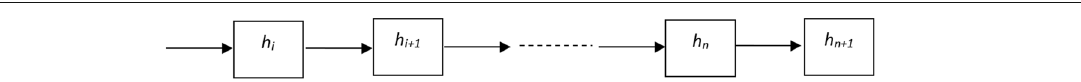
Fig. 5 An interactive connection chain. Host h i can only know host h i +1 is connected with it. It has no idea about the connecting situation after